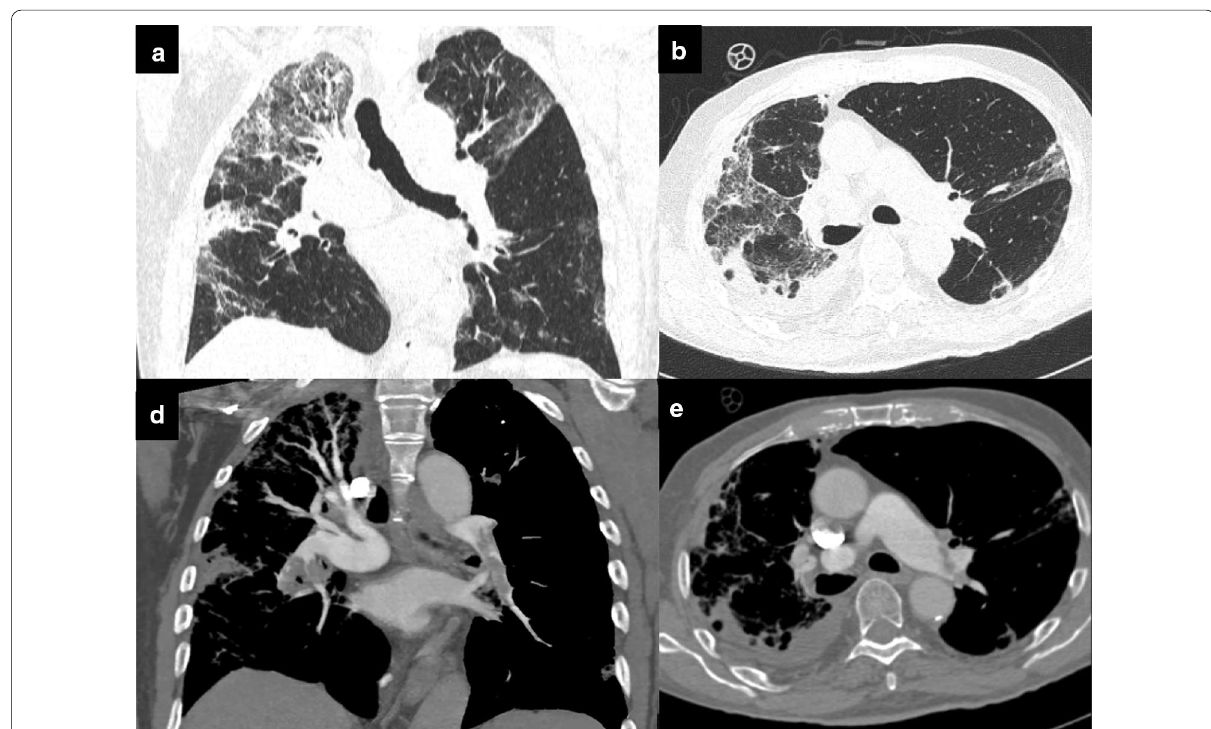
Fig. 7 Pulmonary Embolism. COVID-19 patient with dyspnea, increased D-dimer levels and O2 saturation < 93. Chest CT evidenced GGO with interstitial thickening of the interlobular and intralobular septa, together with pleural effusion ( a , b ). After contrast media injection, PE was found in the left upper lobar branch, the left inferior lobar branch and the segmental arteries for the left inferior pulmonary lobe and PE of the interlobar arteries for the inferior right lobe, probably extended to the subsegmentary arteries ( d , e ). CT computed tomography; GGO ground glass opacity;